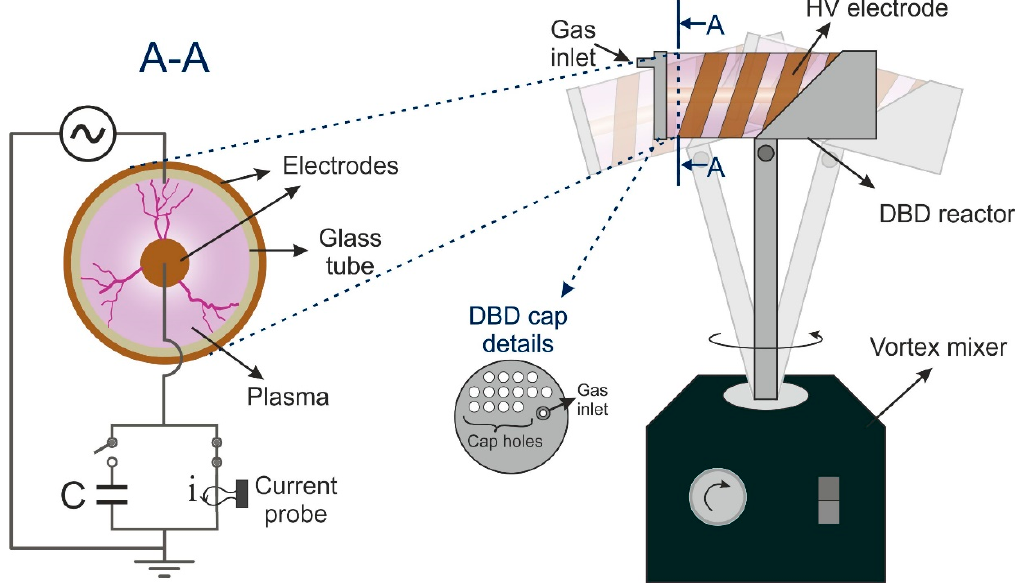
Figure 1. Experimental setup of the coaxial DBD reactor used for seed treatment.